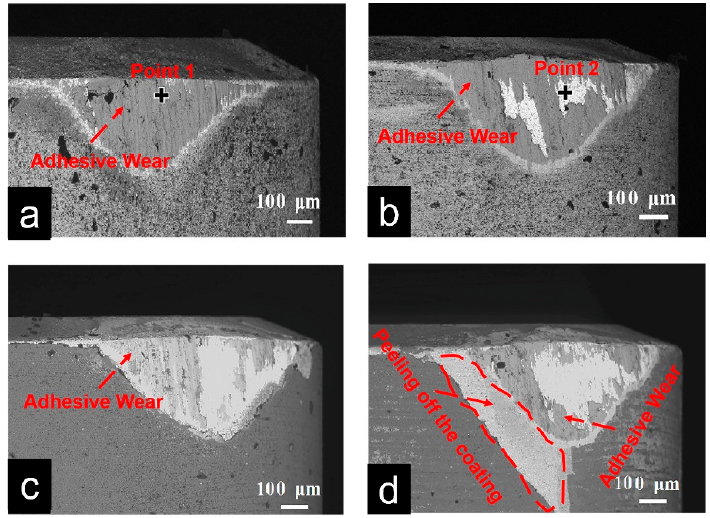
Figure 14. Morphology of flank wear for WC-Ni-Zr cutters, ( a ) FN1-1, ( b ) FN1-2, ( c ) FN1-3, and ( d ) FN1-4. Table 3. The EDS results of Points 1 and 2 in Figure 13.